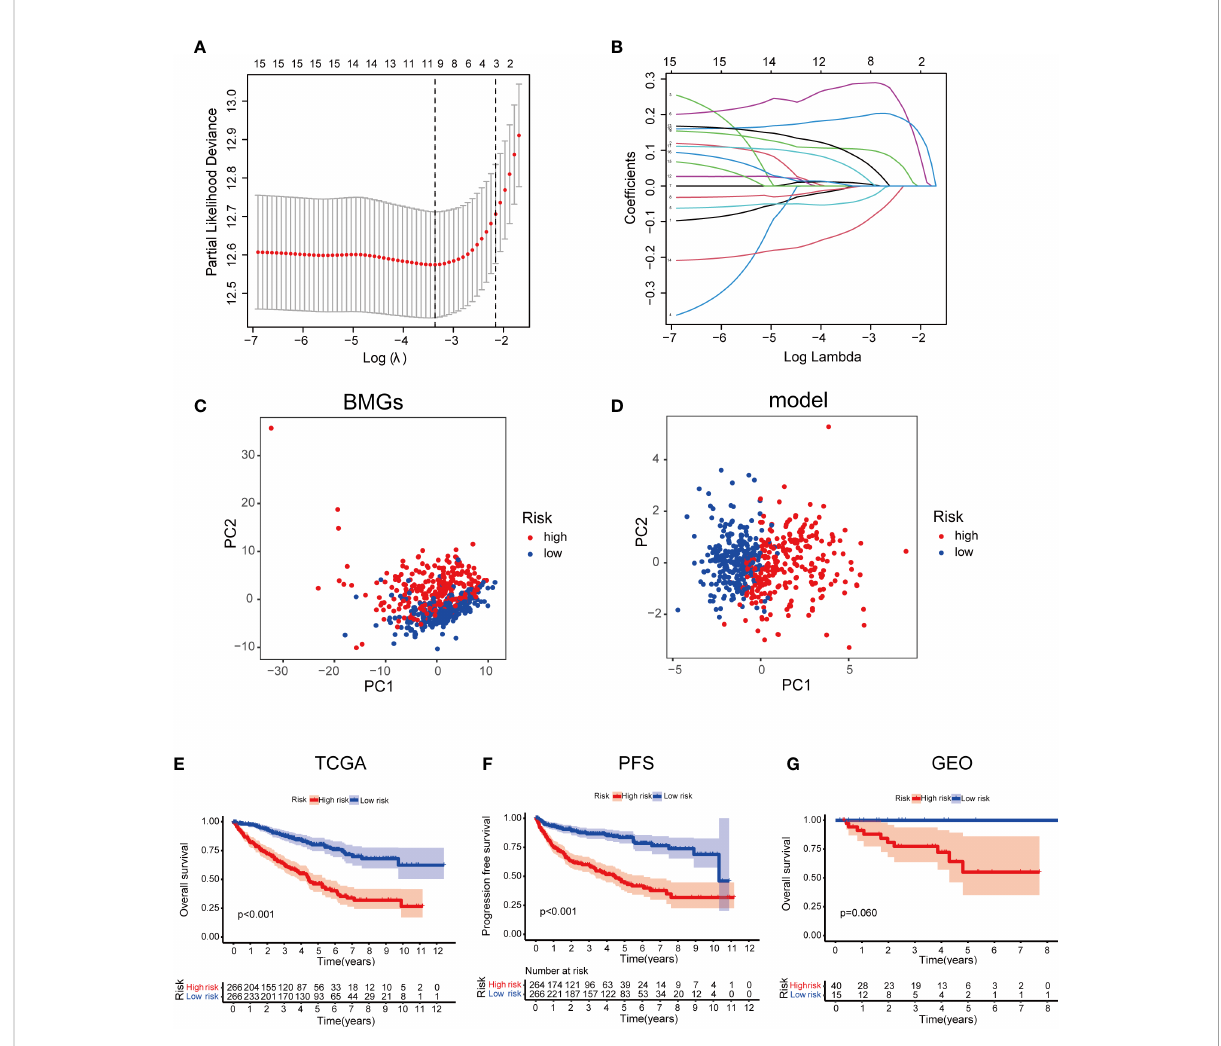
FIGURE 4 Developing a PRS model using 10 BMGs. (A) Identi fi cation of 10 BMGs for a PRS model. (B) The LASSO coef fi cients of the 10 BMGs. (C) PCA on the basis of BMGs in KIRC. (D) PCA on the basis of risk scores to discriminate low- and high-risk score patients in the TCGA cohort. (E) Kaplan – Meier survival curves of OS in LRS and HRS groups in the GEO cohort. (F) Kaplan – Meier survival curves of OS in LRS and HRS groups in the TCGA cohort. (G) The comparison of PFS between LRS and HRS groups in the TCGA